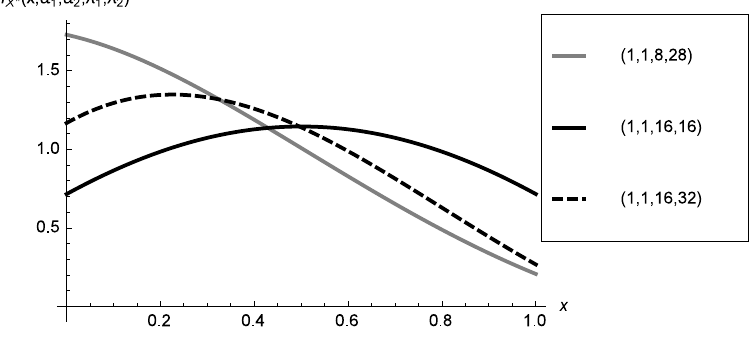
Figure 11 { Plots of the density of X ′′ (cid:24) CDNCB ( (cid:11) 1 ; (cid:11) 2 ; (cid:21) 1 ; (cid:21) 2 ) for (cid:11) 1 = (cid:11) 2 = 1 and selected values of (cid:21) 1 ; (cid:21) 2